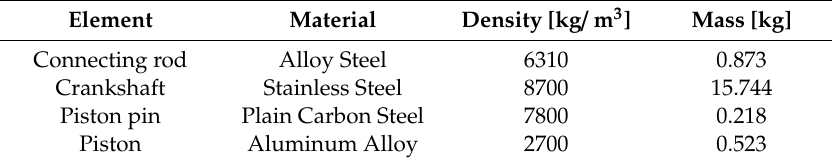
Table 2. Materials used in the mechanism simulation.